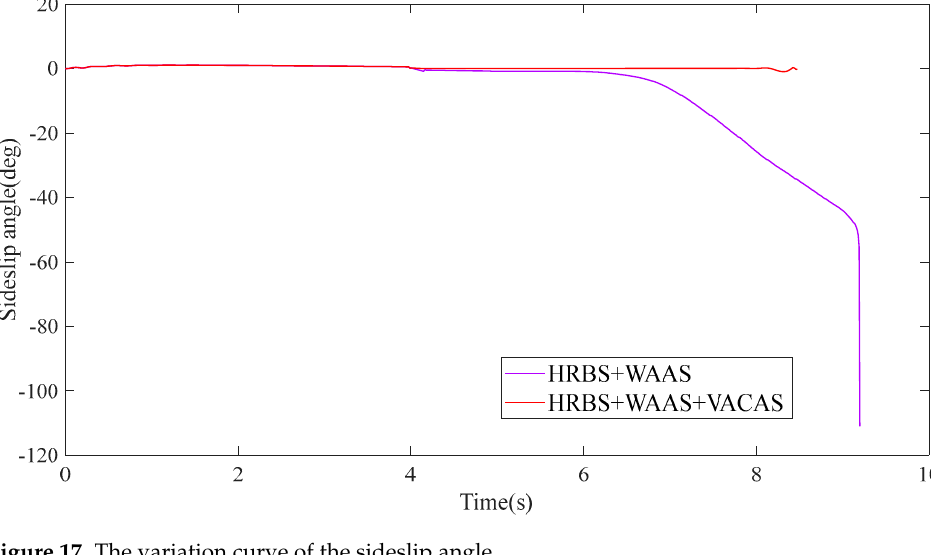
Figure 16. The variation curve of acceleration.